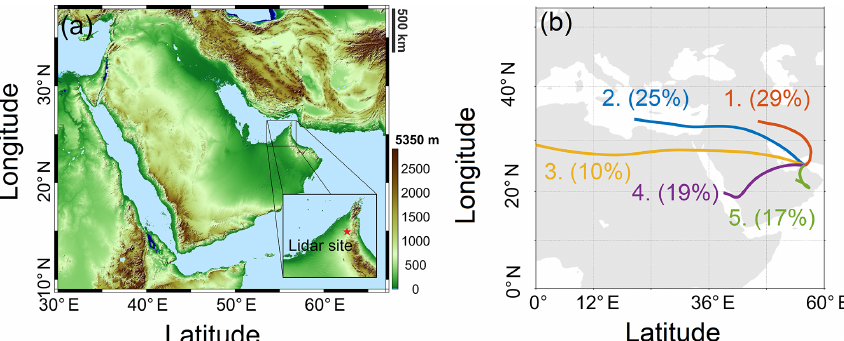
Figure 1. (a) Digital elevation map (DEM) from the NASA Shuttle Radar Topographic Mission (SRTM) for the greater area under study. The colour bar values correspond to the altitude above sea level. The site location is shown in the bottom right of this figure with a red star. (b) Cluster analysis of sources of the detected night-time aerosol layer in the region computed with HySPLIT over the course of the campaign period. Coloured lines indicate the trajectory path and the numbers show the percentage share of each trajectory path.